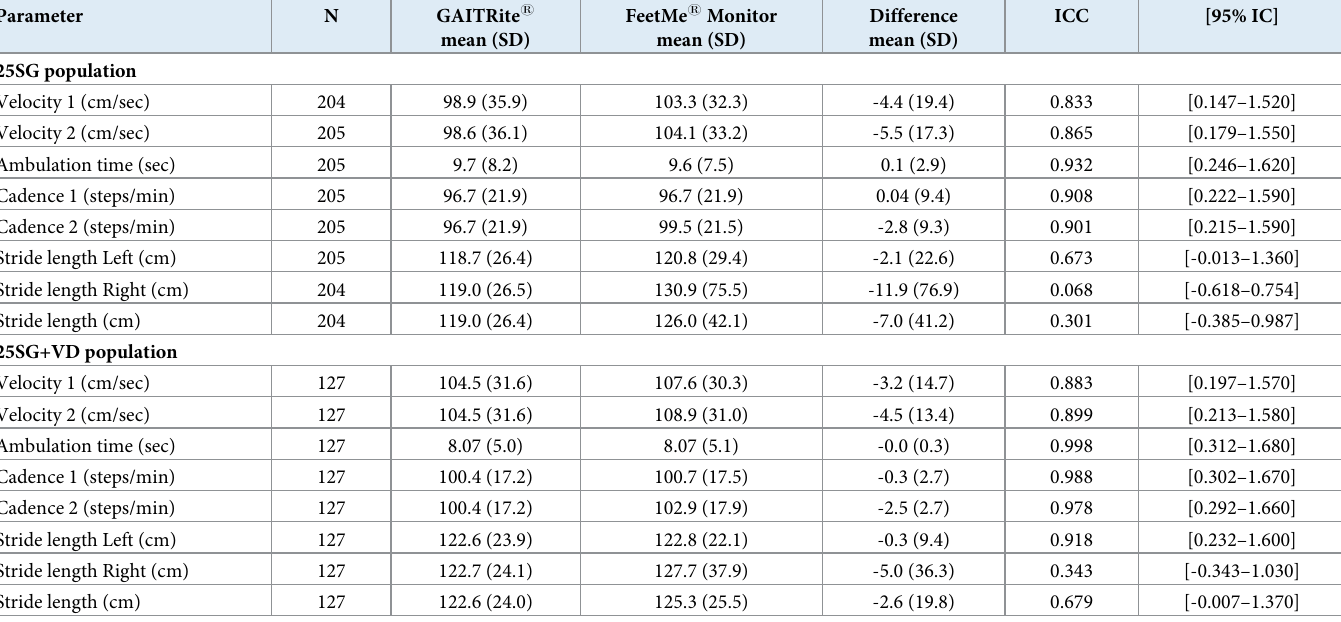
Table 3. Statistics obtained in the paired analysis (25SG and